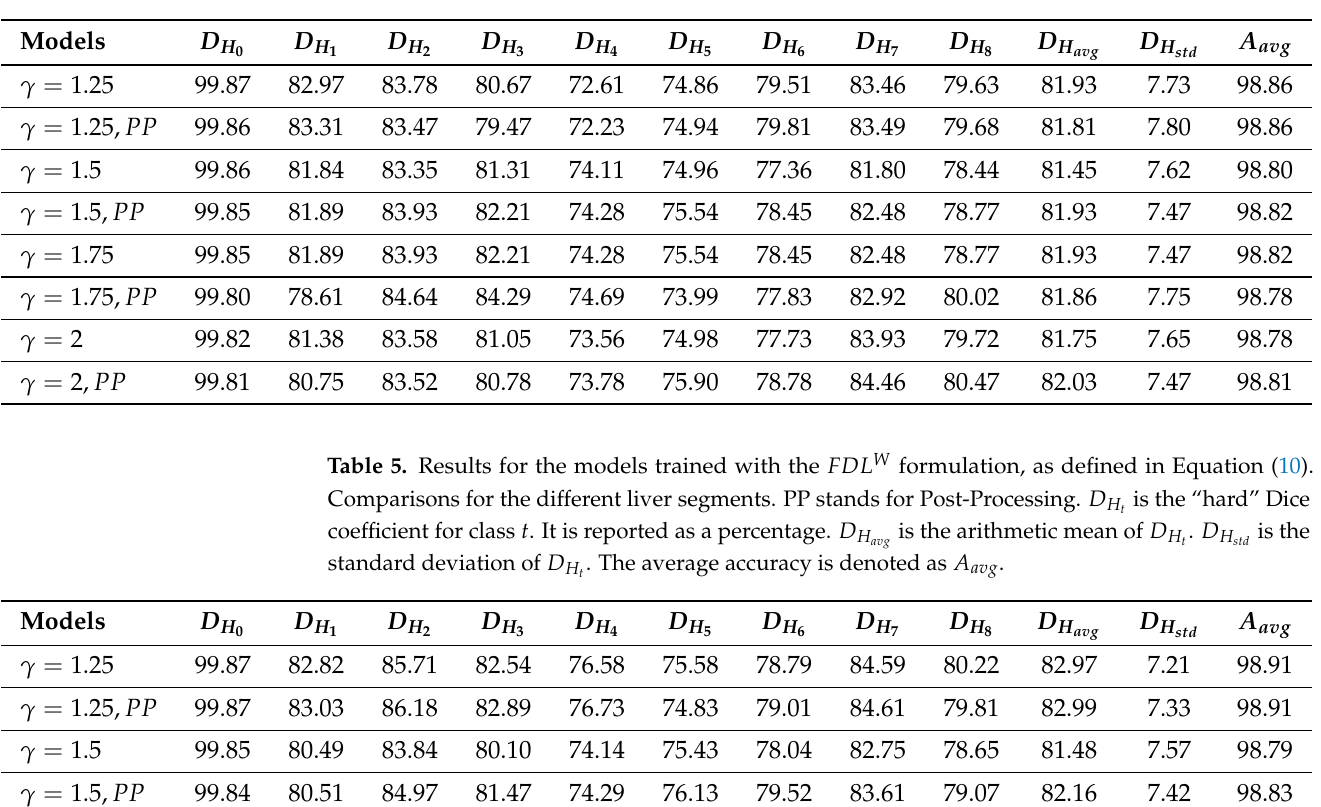
is the “hard” Dice t is the arithmetic mean of D H . D H is the avg t std